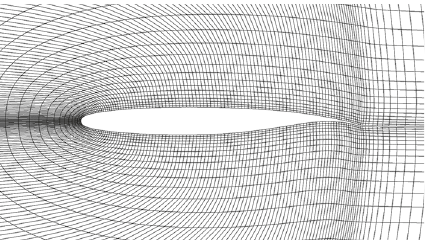
Figure 10: Closeup of Euler mesh optimized with curvature control functions but without orthogonality functions, showing the impact of curvature functions when compared to Figure